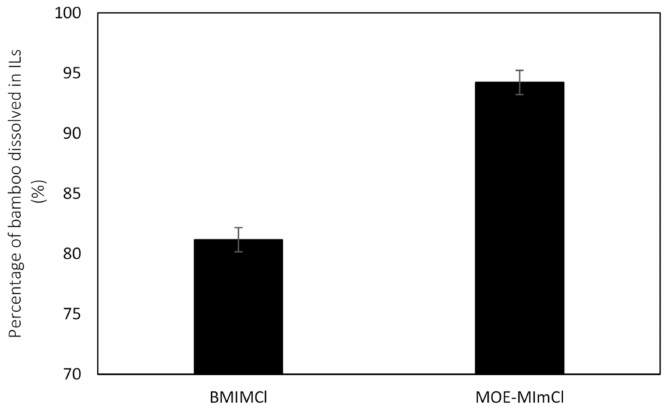
Figure 9. Dissolution of bamboo in MOE-MImCl and